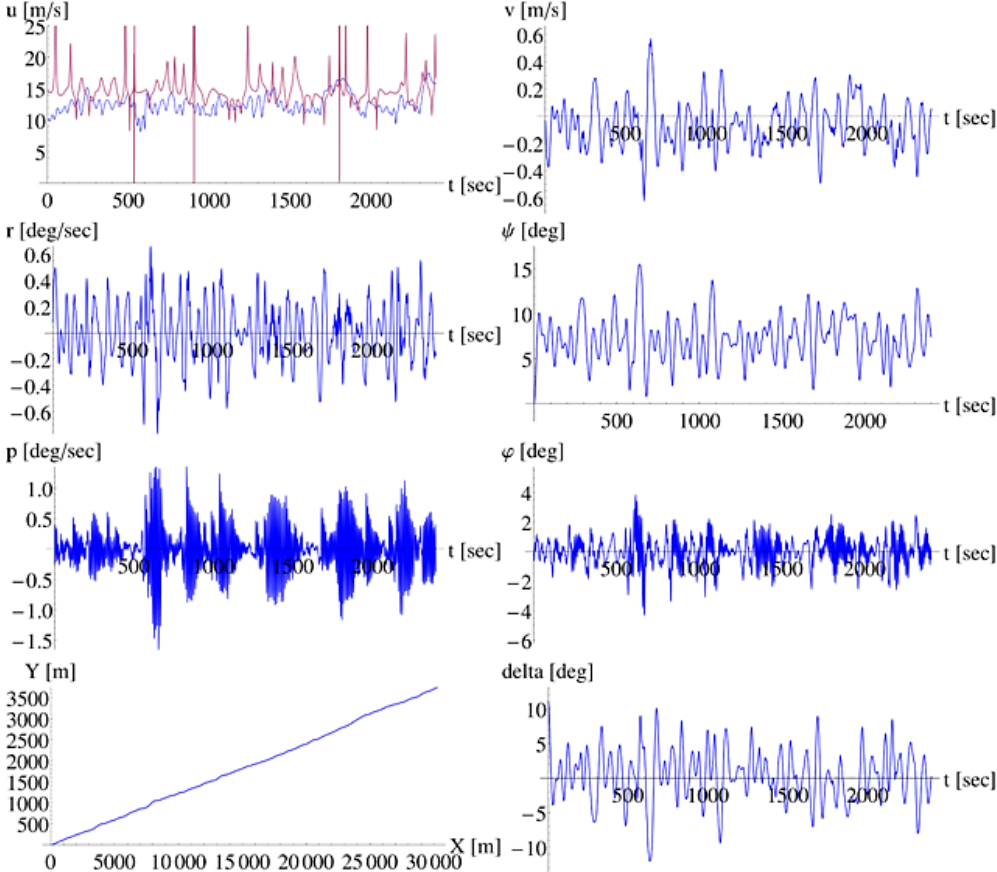
Figure 4. Simulation results for a PD rudder control scenario. In the diagram concerning the history of surge, the blue line corresponds to the nominal speed, while the red line corresponds to the instantaneous celerity ( GM = 3.0 m, 𝜓 (cid:2928) = 7.5 (cid:2925) ).